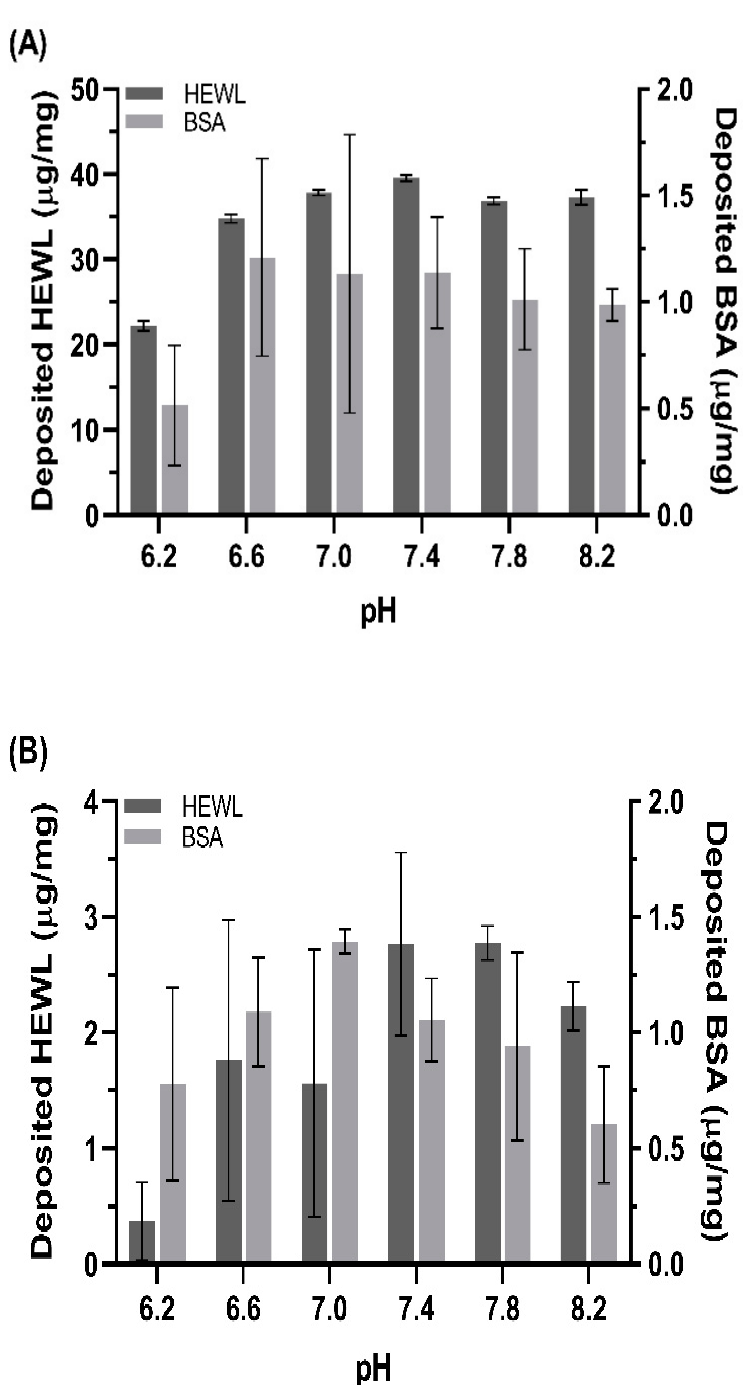
Figure 1. The amount of deposited hen egg white lysozyme (HEWL, ■ ) and bovine serum albumin (BSA, ■ ) on ( A ) etafilcon A and ( B ) hilafilcon B in a range of pH.